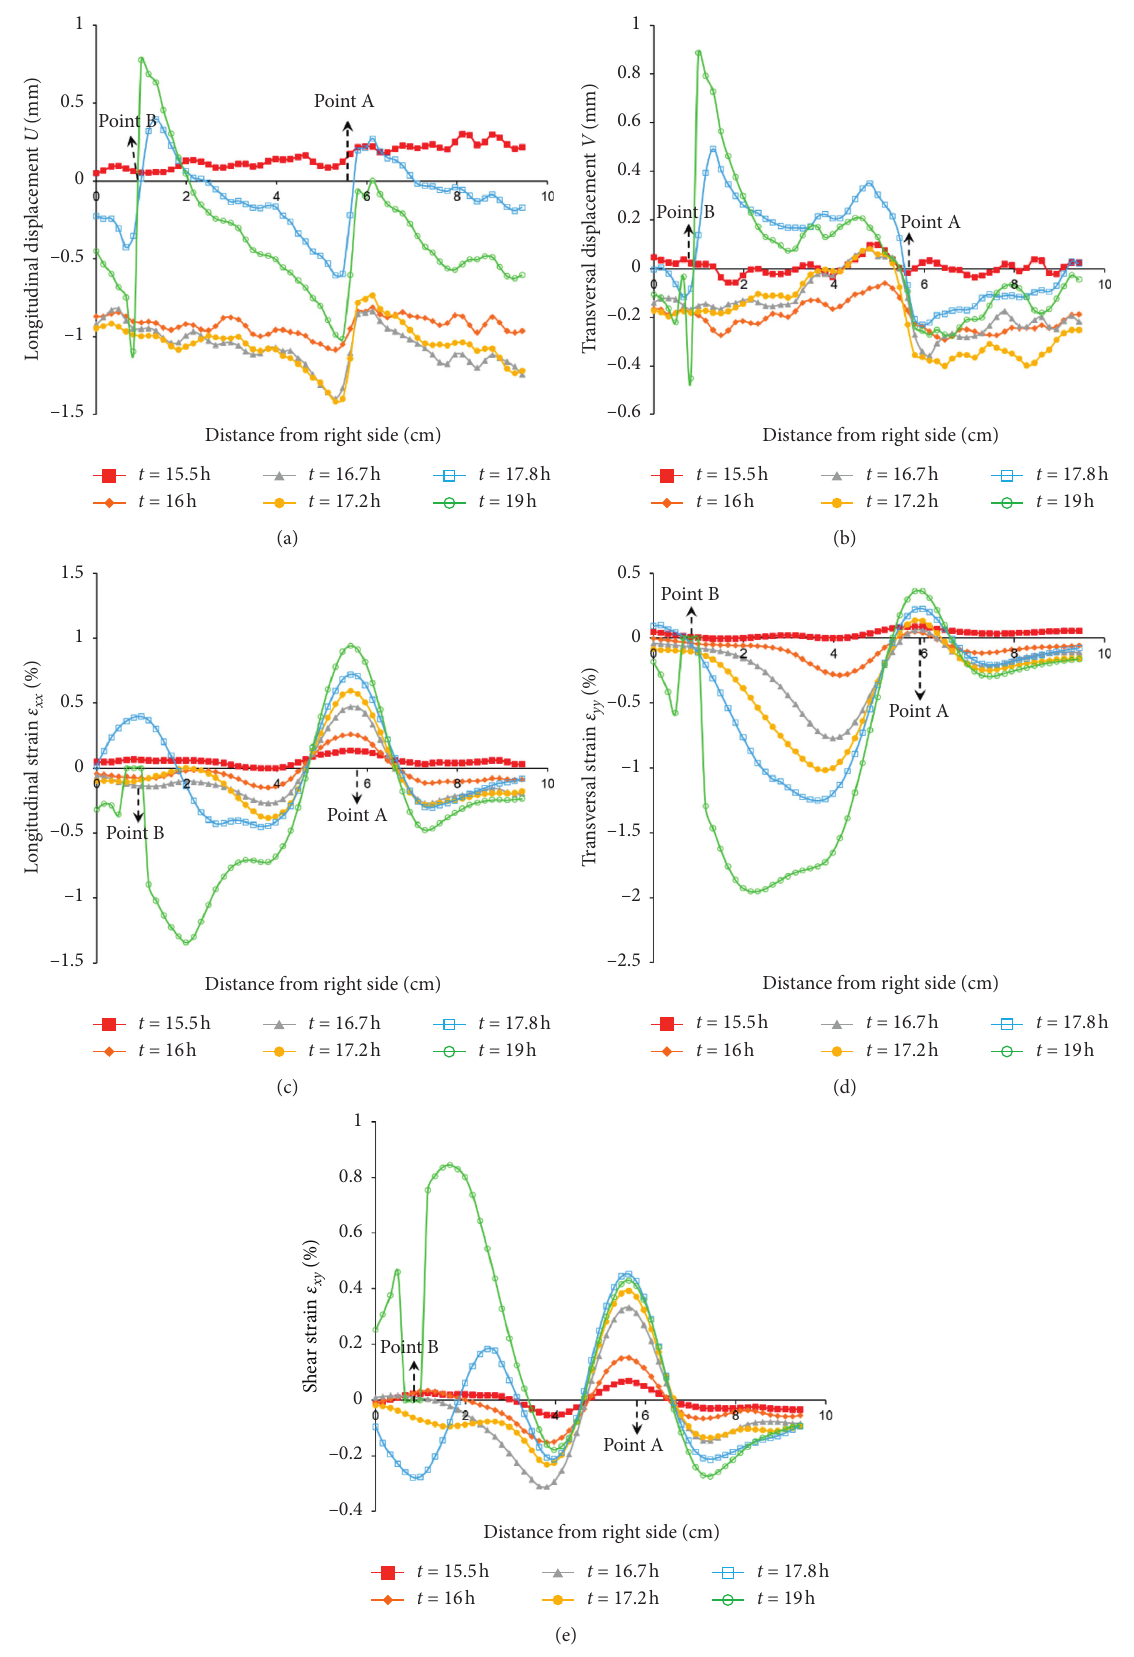
Figure 13: Evolution of U, V , ε xx , ε yy , and ε xy along section 1. (a) Longitudinal displacement longitudinal strain ε xx ; (d) transversal strain ε yy ; and (e) shear strain ε xy